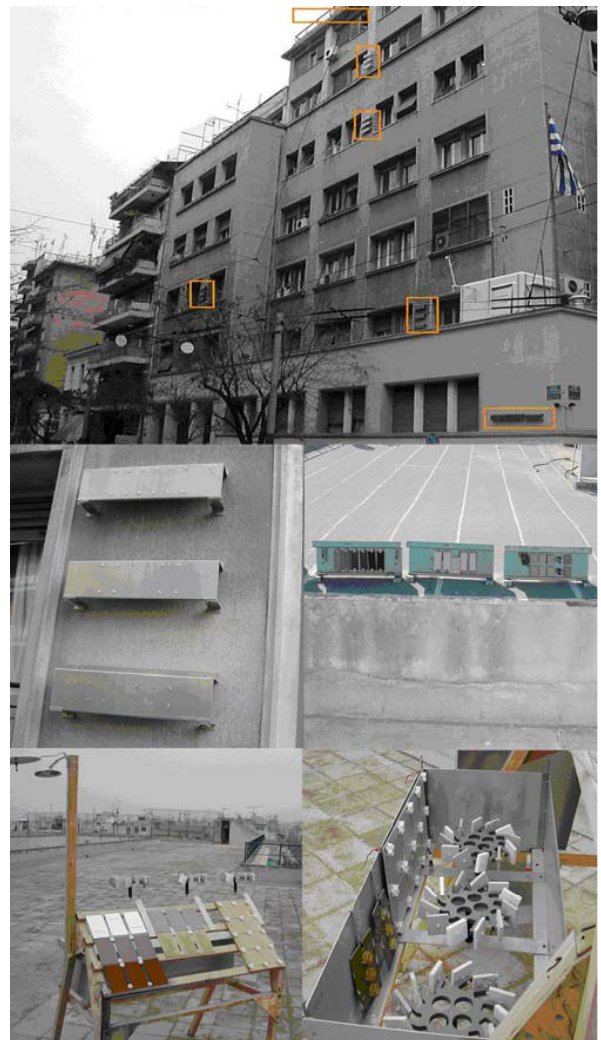
Fig. 1. The exposure site in Athens, Greece. The top panel shows the aluminium racks mounted at the heights of 3, 6, 9, 15, 18 and 21m (not visible from this side), on a building, located in the Athens centre. The middle panel shows the group of three aluminium racks (on the left) with the specimens (on the right) which were distributed on the south facade of the building. The bottom panel shows the wooden rack (main rack) which was installed on the roof and consisted of an inclined plane (on the left) and an aluminium box with open bottom (on the